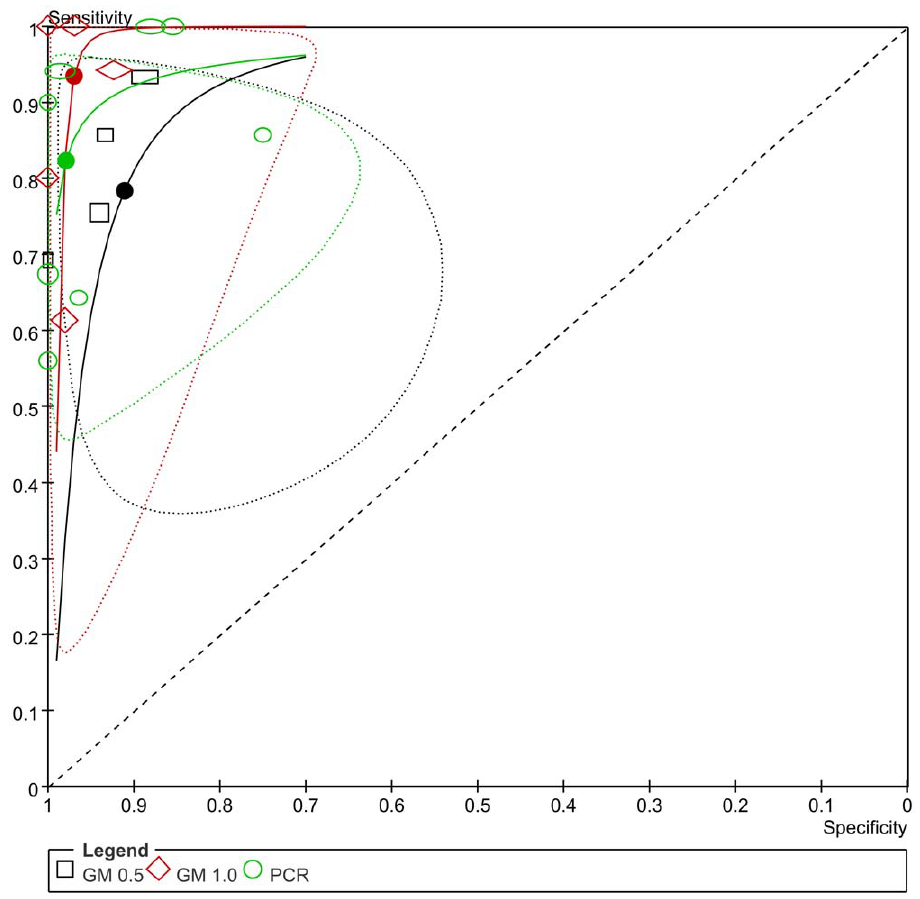
Figure 9. Summary ROC plot of SEN and SPE of PCR and BAL-GM. (Dotted ellipses around the spots represent the 95% CI around the summary estimates. The circles, diamonds and rectangles represent individual studies and the size is proportional to the number of patients included in the study).